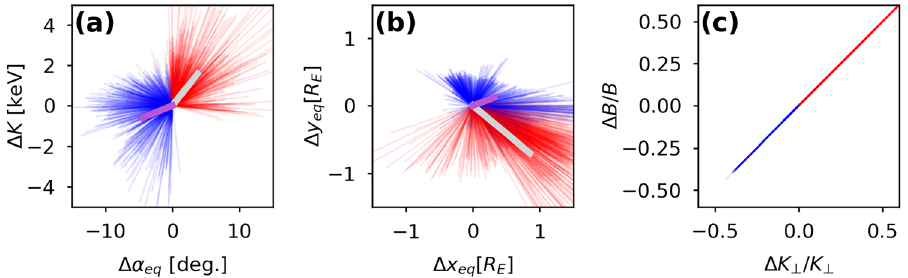
Figure 4. Over the course of the simulations, electron populations from the regions of parallel and perpendicular anisotropies, shown in Fig. 2, do not overlap and undergo changes that point to the betatron affect as the mechanism of their generation. The figure shows the changes in the electron energy and pitch- angle (panel ( a ), equatorial location (panel ( b )), and the equatorial values of the electron perpendicular energy and total magnetic field intensity at electron location (panel ( c )) at the end of the 30 s simulation interval for particles in the regions of parallel (blue color) and perpendicular (red color)